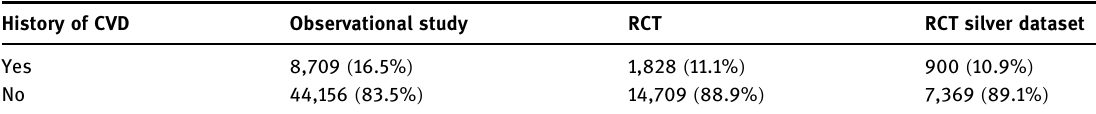
Table A8: Distribution of history of cardiovascular disease in the observational study, RCT, and RCT silver datasets History of CVD